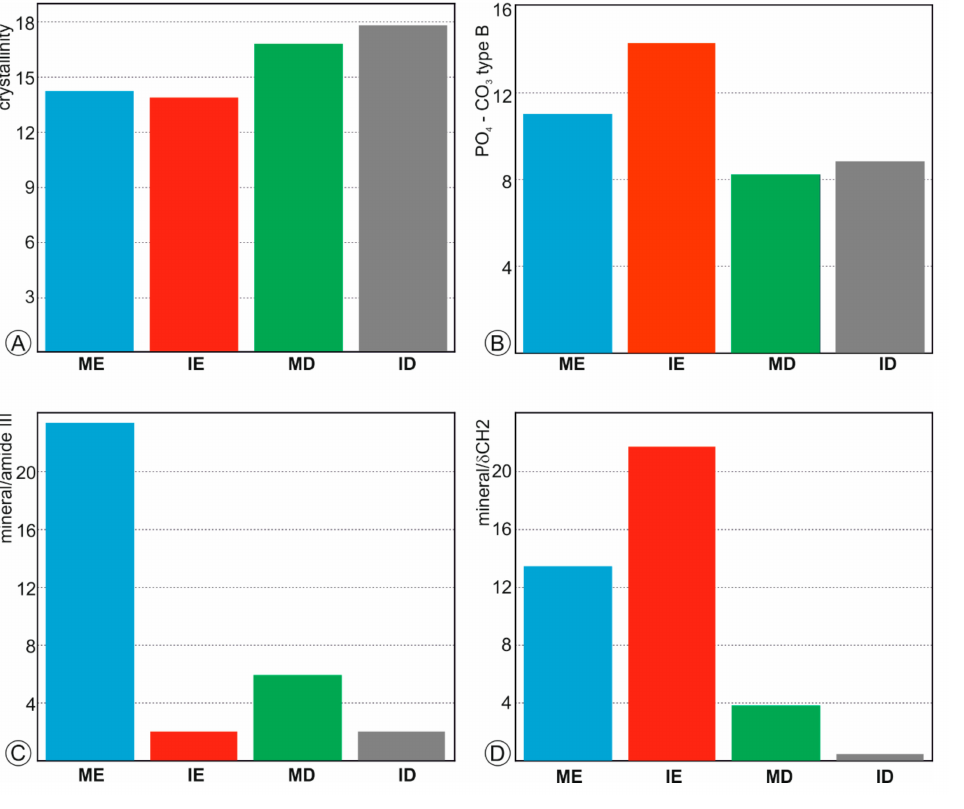
Figure 8. Bulk composition of teeth extracted from regurgitation pellets. ( A )—Crystallinity index calculated from the FWMH of the ν 1 PO 43- peak. ( B )—Substitution of ions PO 43 − (961 cm − 1 peak) to CO 32 − B type (1070 cm − 1 peak); ( C )—Mineral-organic ratios calculated from the surface of ν 1 PO 43 − divided by the surface of amide III band. ( D )—Mineral-organic ratios calculated from the surface of ν 1 PO 43 − divided by the surface of δ (CH 2 ) band. ME: molar enamel, IE: incisor enamel, MD: molar dentine, ID: incisor